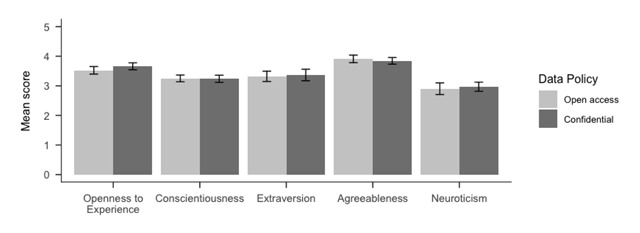
Mean scores with 95% confidence intervals by subscale of the French Big Five personality questionnaire (Plaisant et al., 2010). Answers given on 5-point Likert scales.